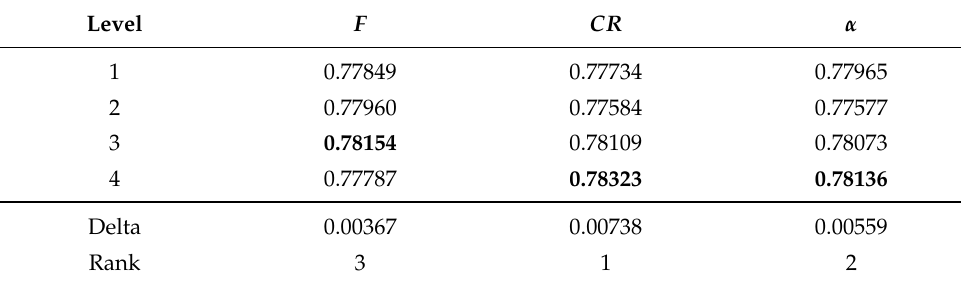
Table 3. Average HVs and the Rank of Each Parameter.